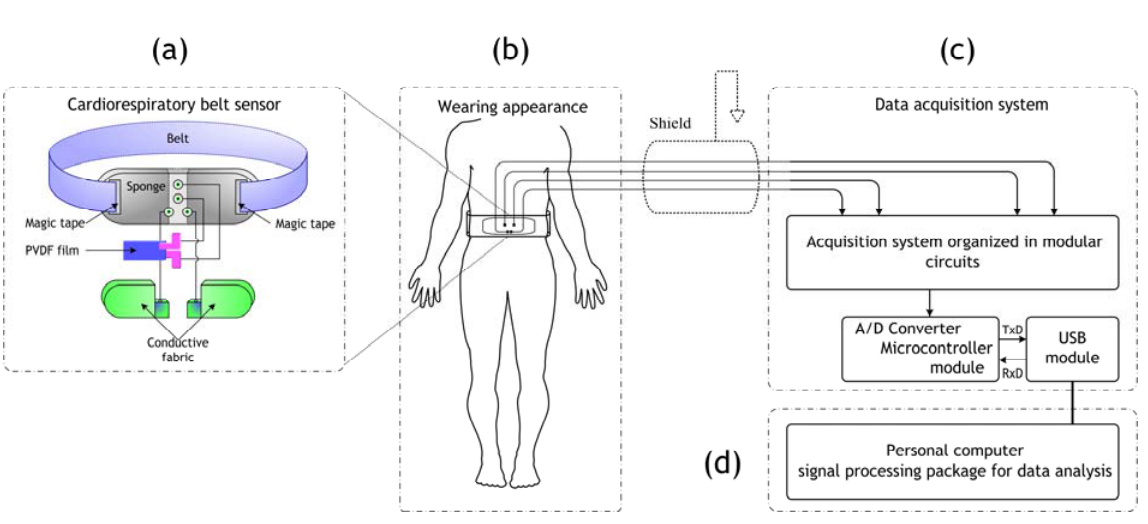
Figure 1. Overview of the cardiorespiratory belt sensor system. (a) Cardiorespiratory belt sensor. (b) Wearing appearance of the cardiorespiratory belt sensor. (c) Hardware system for signals acquisition. (d) Data processing techniques within personal computer.